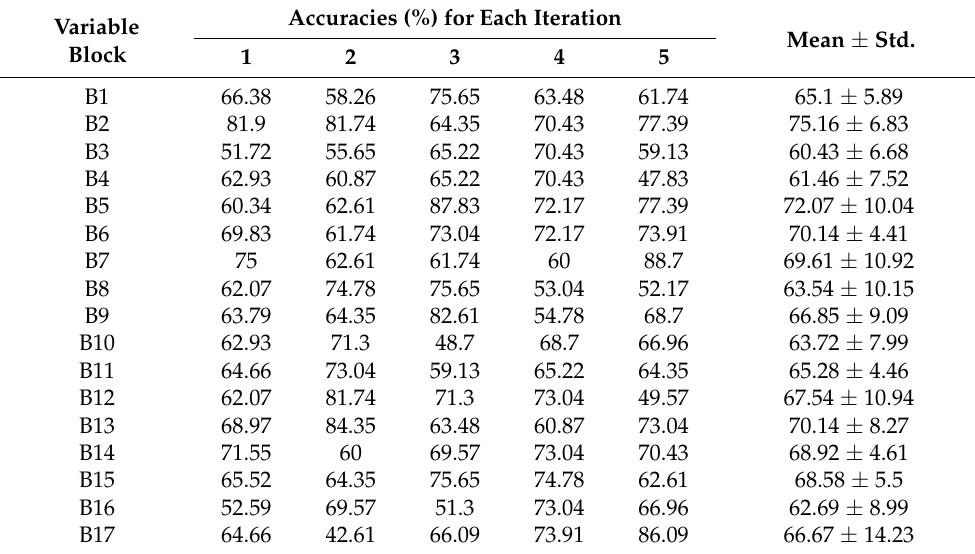
Table 10. Accuracies of different network structure of the proposed dataset for arousal classification. The training and test were repeated five times.